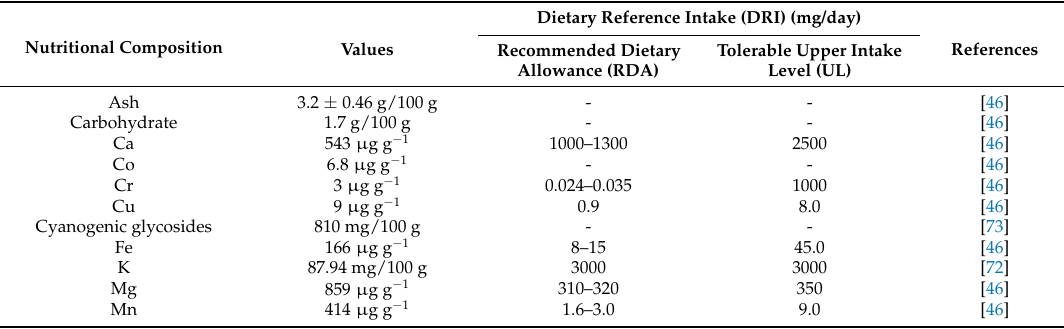
Table 2. Nutritional composition of B. micrantha bark, fruits and leaves.